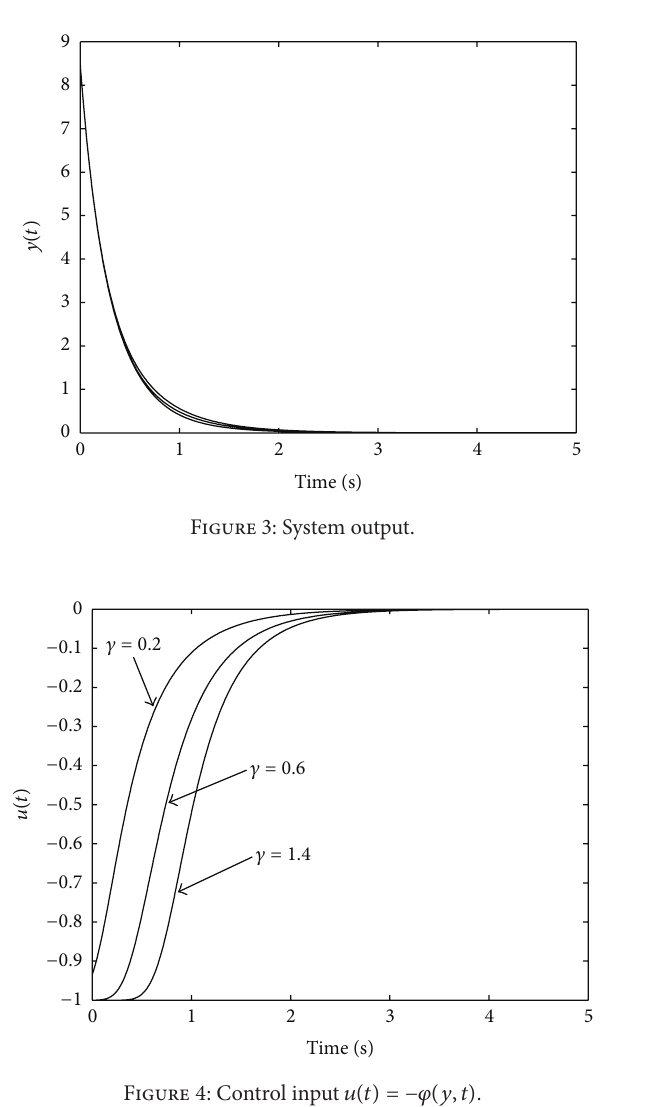
Figure 6: Output of the